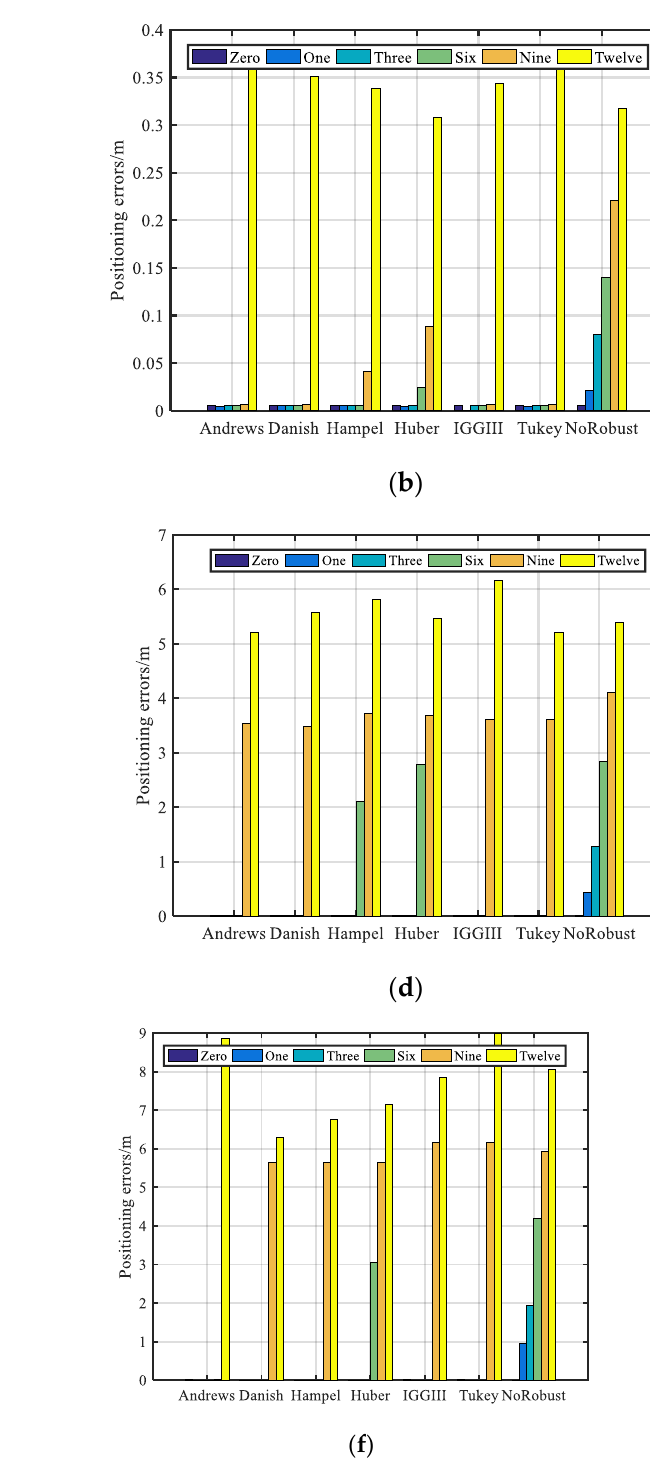
Figure 6. Position errors of different schemes of simulated gross error with different numbers and sizes: ( a ) Epoch 179600; ( b ) Epoch 180,200; ( c ) Epoch 181,400; ( d ) Epoch 182,000; ( e ) Epoch 182,600; ( f ) Epoch 183,200.